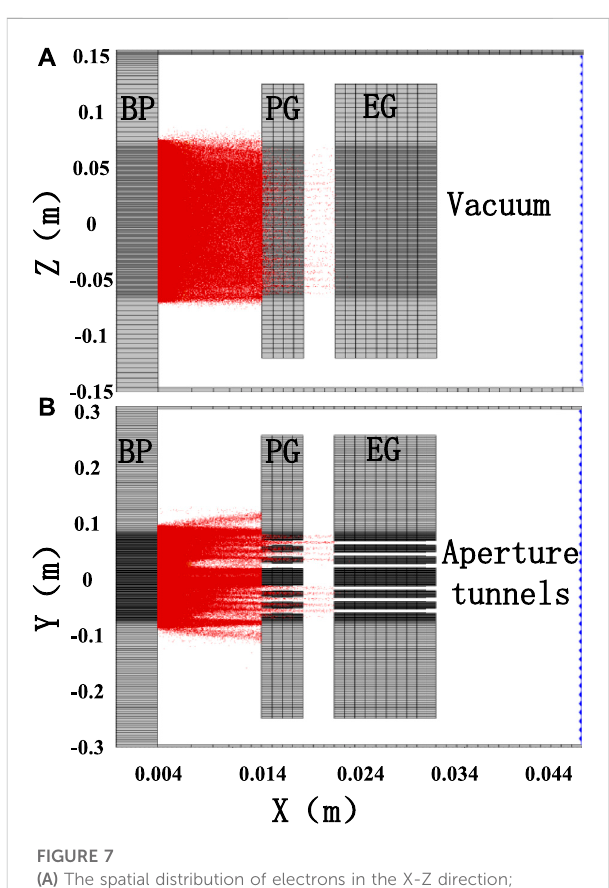
FIGURE 7 (A) The spatial distribution of electrons in the X-Z direction; (B) .The spatial distribution of electrons in the X-Y